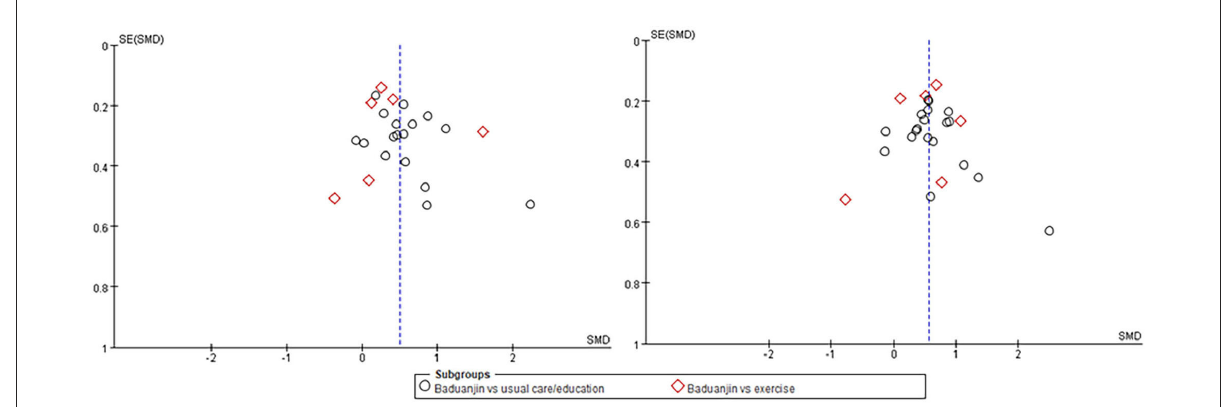
FIGURE6 The funnel plots for Badunjin exercises for type 2 diabetes in fasting blood glucose (left) and glycosylated hemoglobin